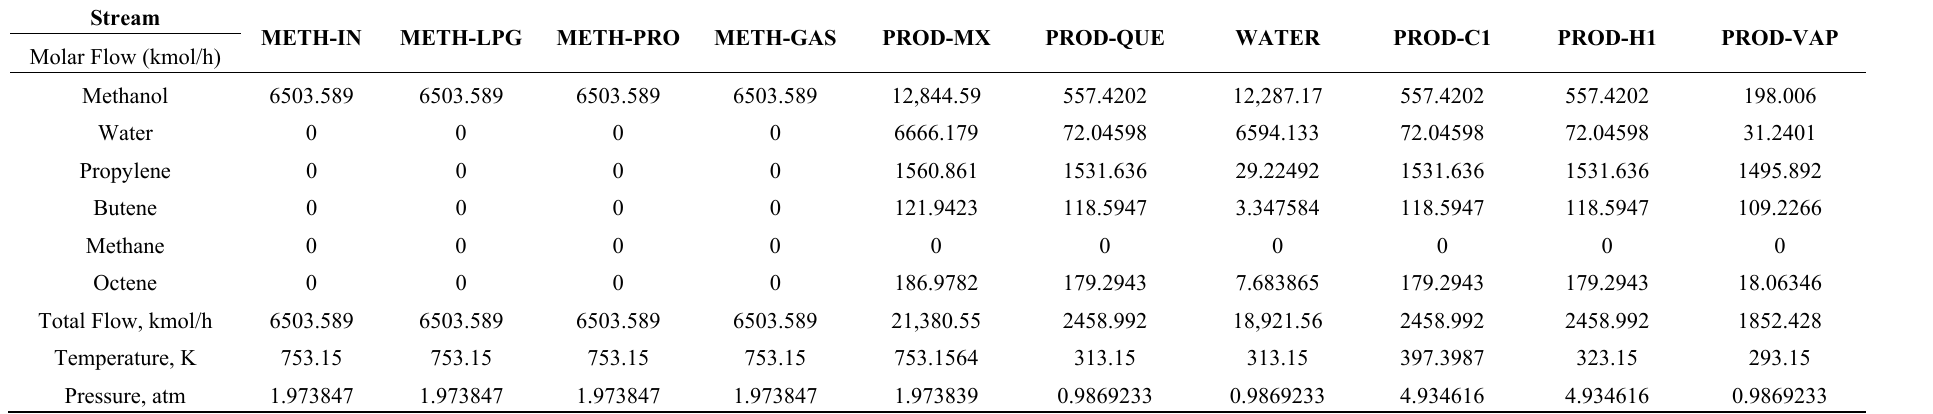
Table A2. The stream data for the methanol to propylene (MTP)